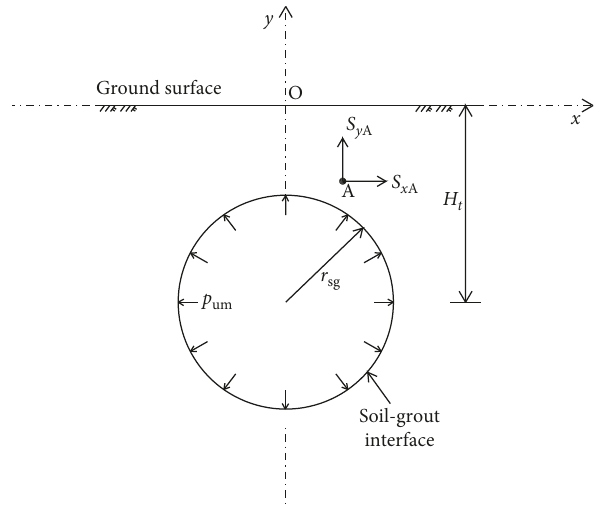
Figure 2: Parameters needed for calculating the ground dis- placement in case of a uniform stress applied at the cavity boundary (soil-grout